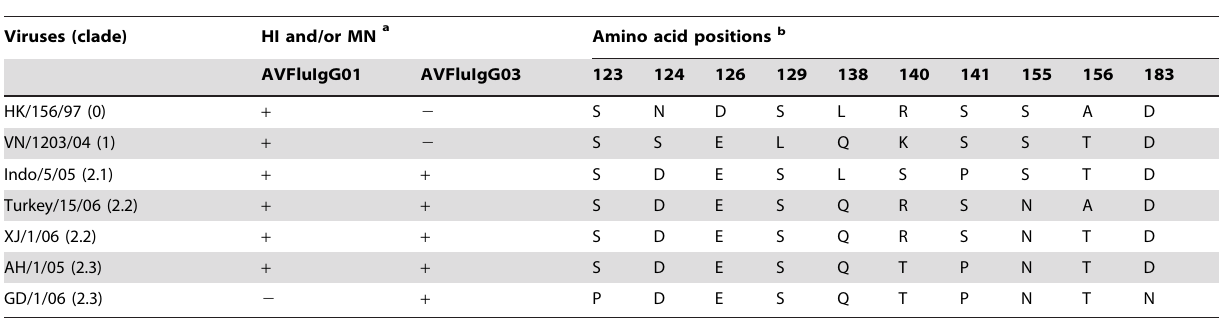
Table 5. Amino acid changes in HA1 of the H5N1 viruses isolated from humans